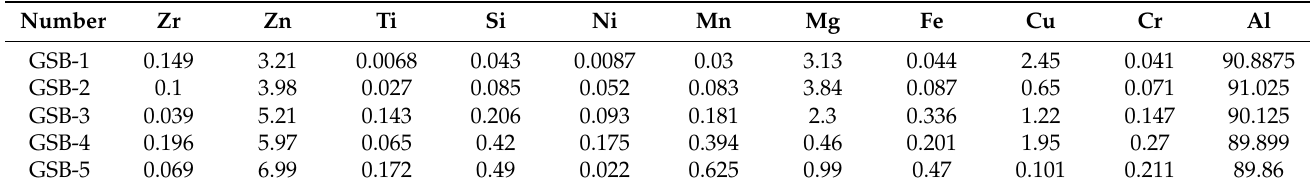
Table 2. The chemical composition of B4 series spectral standard samples